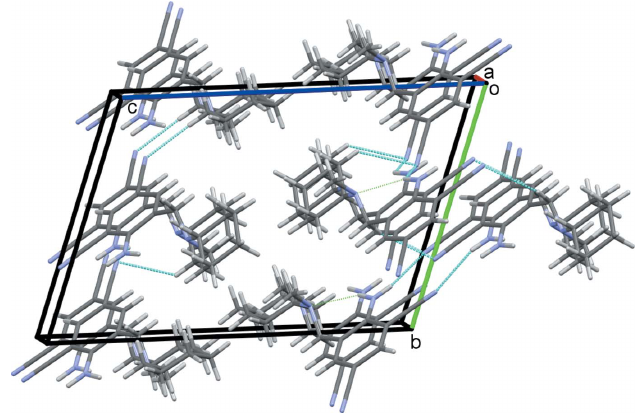
Figure 2 The overall packing of the title compound, with hydrogen bonds drawn as dashed lines.